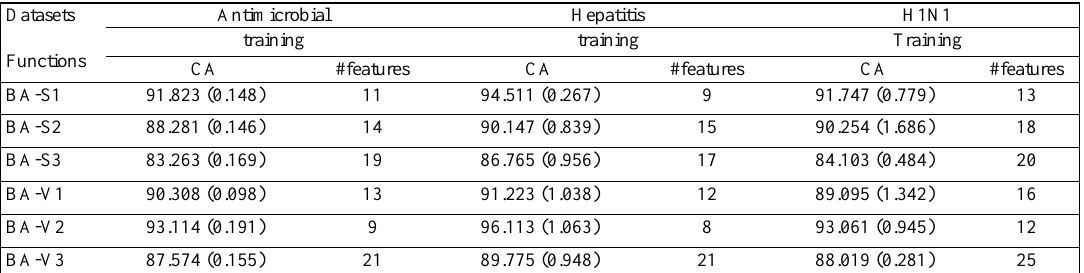
Table 2. Methods performance evaluation (on average) according to the training datasets with the standard deviation is between parentheses